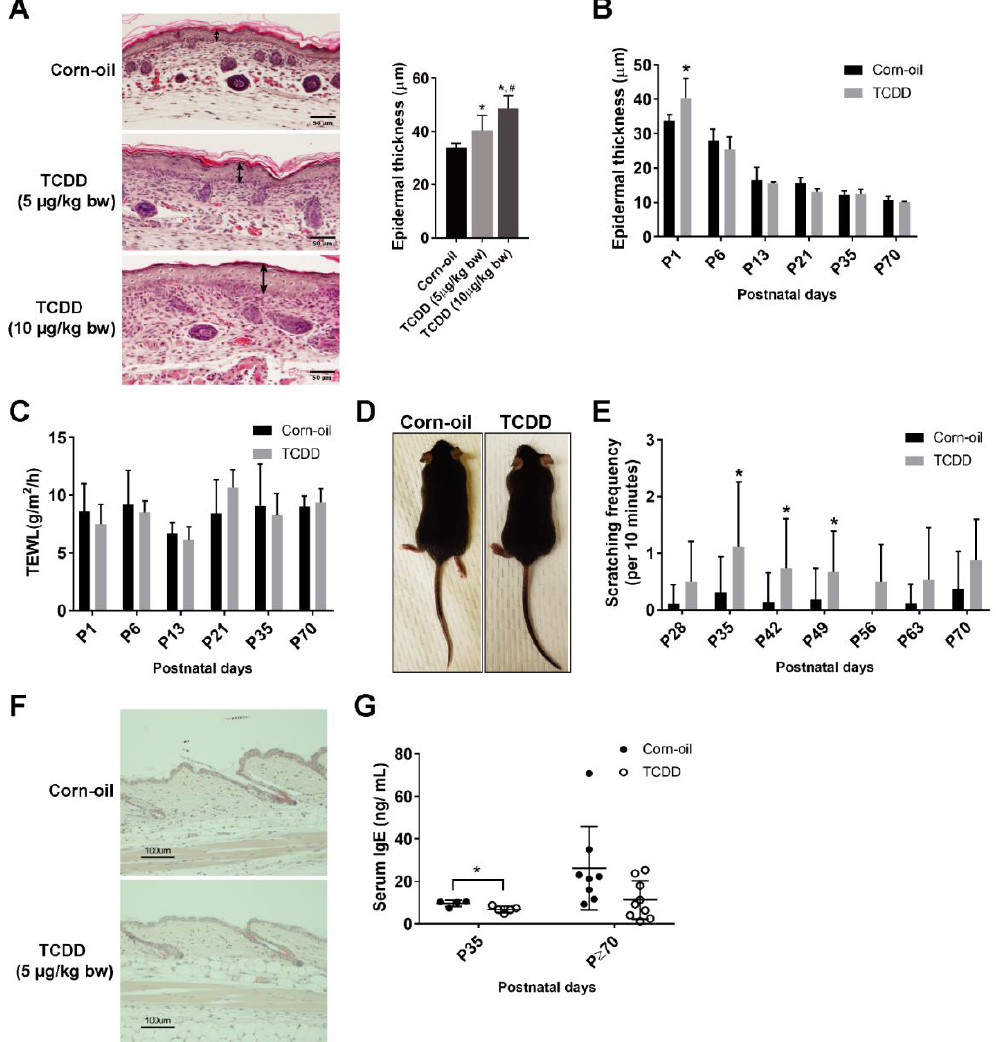
Figure 2. Cutaneous effects of in utero and lactational exposure of mice to TCDD. Time-mated mice were treated by gavage with either corn- oil or TCDD [5 μg /kg bw ( A – H ) or 10 μg /kg bw ( A )] at E12 and pups were examined for cutaneous effects at the indicated postnatal day. (A) Histological analyses of murine pup skin at P1 following the indicated treatments. Representative images of formalin-fixed, paraffin-embedded tissue sections stained with H&E, Scale bar = 50 µm. Double- headed arrows indicate the epidermal thickness. Quantitation of epidermal thickness by microscopy ( n = 5 – 7). Bar graph displays the mean values ± SDs. ( B ) Quantitation of epidermal thickness by microscopy at the indicated postnatal day ( n = 4 – 6). Bar graph displays the mean values ± SDs. ( C ) Barrier function measured by TEWL ( n = 6). Bar graph displays the mean values ± SDs. ( D ) Representative image of the appearances of the corn-oil- and TCDD-treated mice at P35 ( n > 20). ( E ) Frequency of scratching following the indicated treatments at the indicated ages ( n = 8 – 15). Bar graph displays the mean values ± SDs. ( F ) Histological analyses of murine pup skin at P70 following the indicated treatments. Representative images of formalin-fixed, paraffin-embedded tissue sections stained with H&E, Scale bar = 100 µm. ( G ) Serum IgE levels in animals at P35 and ≥ P70 (between P70 and P135) following the indicated treatments. Each symbol represents an individual animal ( n = 4–9). Graph displays the mean values ± SDs. Data were analyzed by a two-tailed Student’s t -test. * p < 0.05, compared to age-matched corn-oil control. # p < 0.05 compared to 5 µ g/kg bw TCDD group. Abbreviations: TCDD, 2,3,7,8-tetrachlorodibenzo- p -dioxin; bw, body weight; E, embryonic day; P, postnatal day; H&E, hematoxylin and eosin; IgE, immunoglobulin E; TEWL, transepidermal water loss; SD, standard